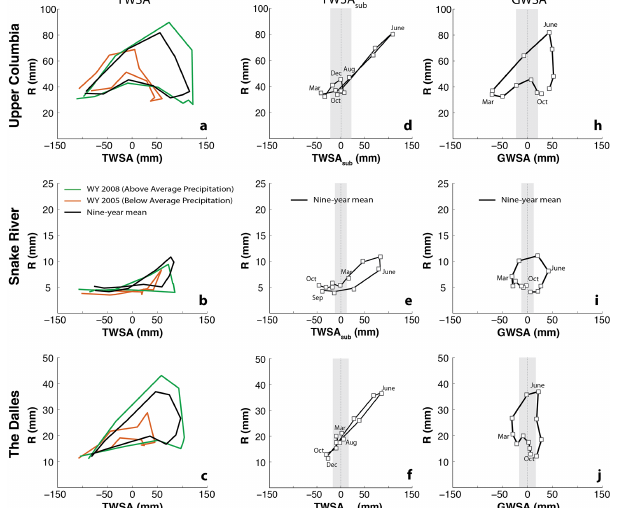
Figure 4. (a–f) Individual hysteresis curves for the three study watersheds for TWSA (a–c) , TWSA sub (d–f) , and GWSA (h–j) . TWSA sub in the Upper Columbia and The Dalles collapses to rep- resent a shape more commonly associated with the hysteresis of a soil matrix. The Snake River retains a similar looping shape. The grey areas in the TWSA sub and GWSA plots provide a visual ref- erence of the TWSA error variance for each watershed. The low topography and high storage capacity of the Snake aquifer provides a consistent groundwater signal, as compared to the limited aquifer of the Upper Columbia, which fills and drains quickly. Note the dif- ferent scales on the y axes.